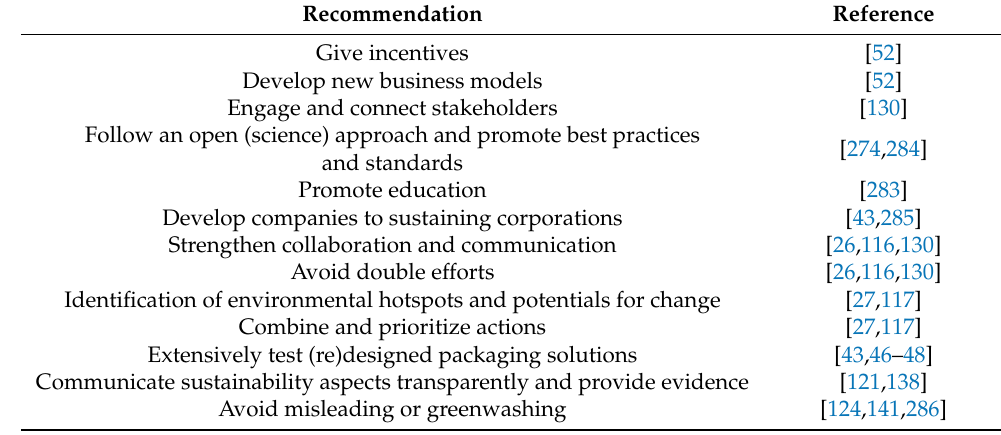
Table 5. Recommendations for management-related activities to promote sustainable